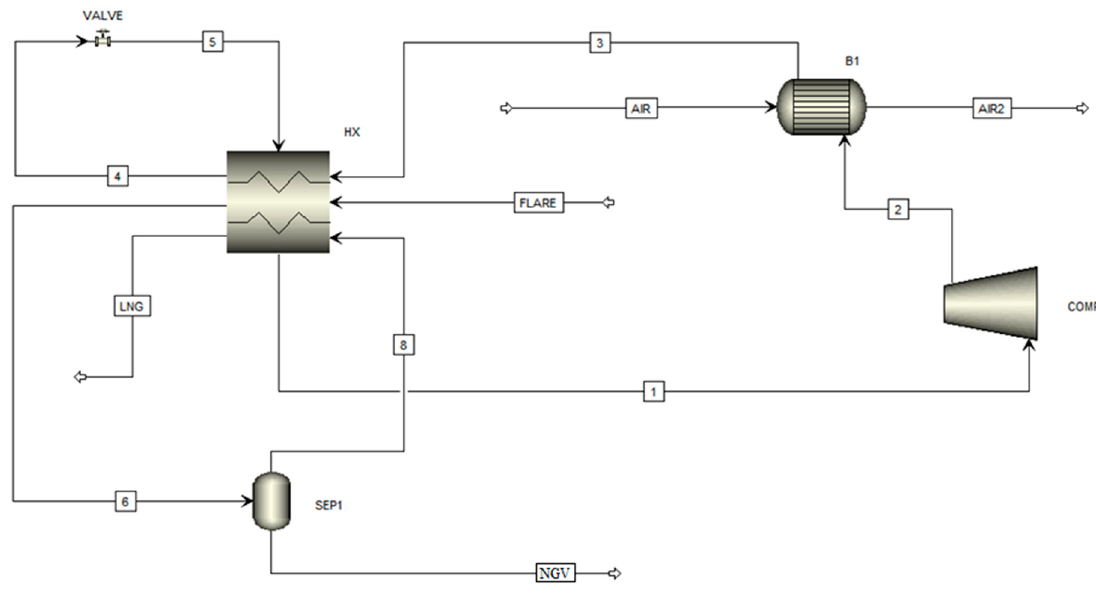
Figure 2. Proposed refrigeration cycle.